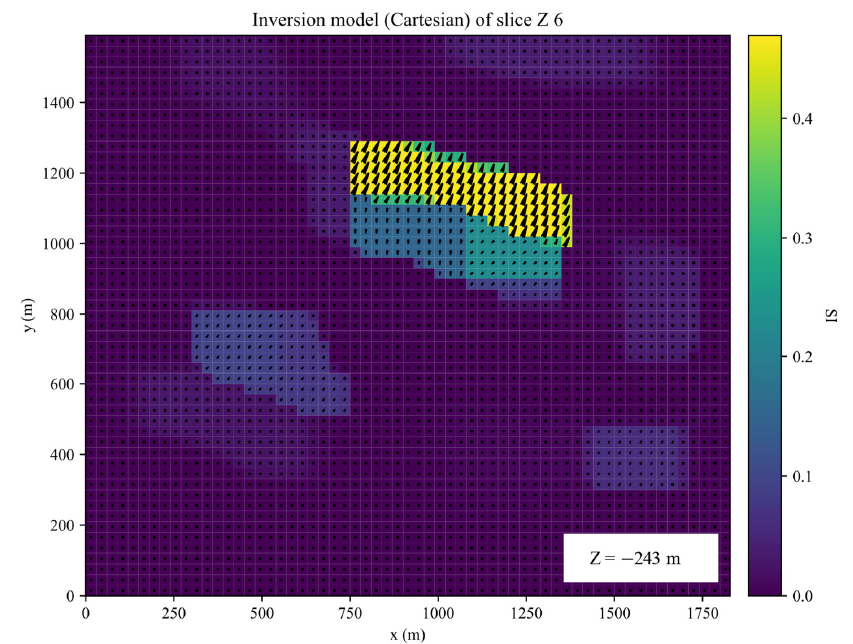
Figure 16. Slices along the Z planes of inverted Galinge iron ore deposit.